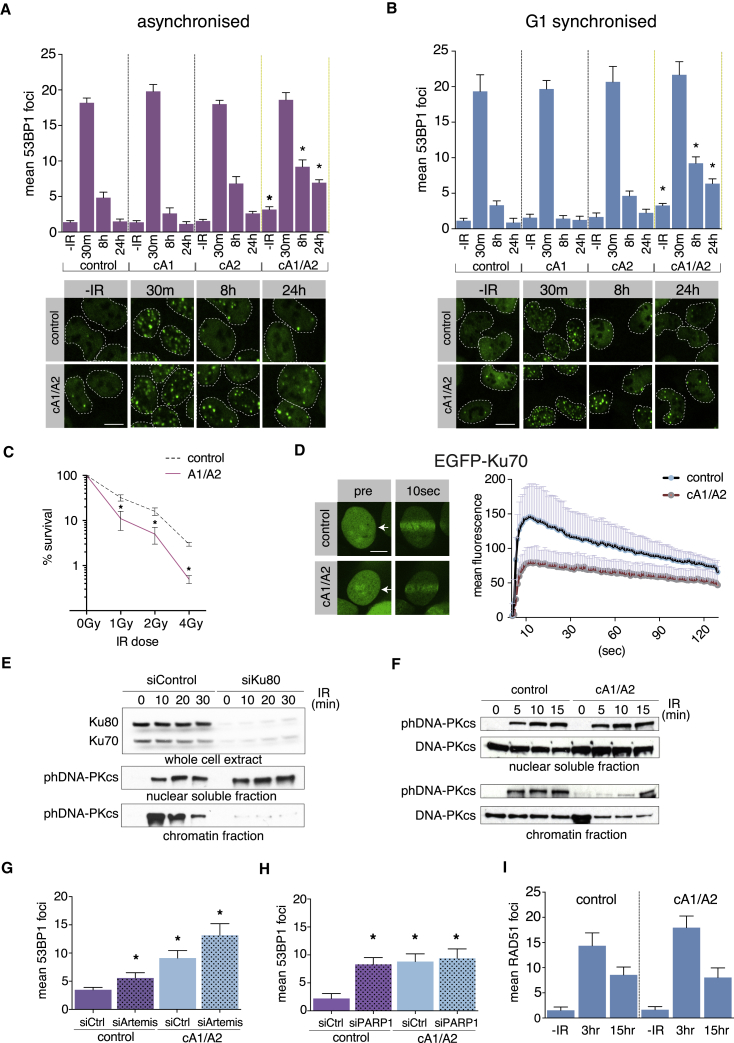
NR4A1/2 Nuclear Receptors Promote DSB Repair in G1(A and B) DSB repair kinetics measured by 53BP1 foci resolution in asynchronized (A) or G1 synchronized (B) NR4A1/2 CRISPR cell lines at indicated time points (m, minutes; h, hours) after 1 Gy radiation. Graph shows mean foci value per nucleus with SEM plotted (n = 3). Asterisks denote statistically significant differences in relation to corresponding control sample (p < 0.05). Control indicates the parental U2OS cell line, cA1 indicates NR4A1 knockout cells, cA2 indicates NR4A2 knockout cells, and cA1/A2 indicates NR4A1/2 double-knockout cells. Images under the graphs show representative nuclei samples (white dashed lines) at indicated time points, showing 53BP1 nuclear stain and DSB foci (green signal). Scale bar, 10 μm.(C) Clonogenic survival assays. Control indicates the parental U2OS cell line, and cA1/A2 indicates NR4A1/2 double-knockout cells. Graph shows relative cell survival at the indicated radiation dose (n = 3; SD plotted on the graph). Asterisks denote statistically significant differences in relation to the corresponding control sample (p < 0.05).(D) Laser microirradiation of EGFP-Ku70 fusion protein in U2OS (control) and NR4A1/2 double-knockout (cA1/A2) cells. Arrow shows the irradiated position in the nucleus. Scale bar, 10 μm. Graph presents the quantification of laser microirradiation experiments (n = 5) with SD plotted above individual data points.(E) Western blotting of Ku70, Ku80, and phosphor-Ser2056 DNA-PKcs (phDNA-PKcs) proteins in U2OS cells transfected with control (siControl) or Ku80-specific (siKu80) siRNAs at indicated time points after 10 Gy irradiation. Top panel shows whole-cell extracts to reveal the extent of Ku80 depletion. Middle panel shows the nuclear soluble fraction. Lower panel shows the chromatin fraction.(F) Western blotting of DNA-PKcs and phosphor-Ser2056 DNA-PKcs (phDNA-PKcs) in either control cells or NR4A1/2 double-knockout cells (cA1/A2) at indicated time points after 10 Gy irradiation. Top panel shows the nuclear soluble fraction. Lower panel shows the chromatin fraction.(G) DSB levels measured as 53BP1 foci count per nucleus after 24 h post-1 Gy irradiation in control versus NR4A1/2 knockouts (cA1/A2) 72 h after transfection with reference siRNA (siCtrl) or Artemis-specific siRNA (siArtemis) (n = 3; error bars represent SEM). Asterisks denote statistically significant differences in relation to the control (siCtrl) sample (p < 0.05).(H) DSB levels measured as 53BP1 foci count per nucleus after 24 h post-1 Gy irradiation in control versus NR4A1/2 knockouts (cA1/A2) 72 h after transfection with reference siRNA (siCtrl) or PARP1-specific siRNA (siPARP1) (n = 3; error bars represent SEM). Asterisks denote statistically significant differences in relation to the control (siCtrl) sample (p < 0.05).(I) RAD51 foci count per nucleus at indicated times after 5 Gy irradiation in control versus NR4A1/2 knockouts (cA1/A2) (n = 3; error bars represent SD).